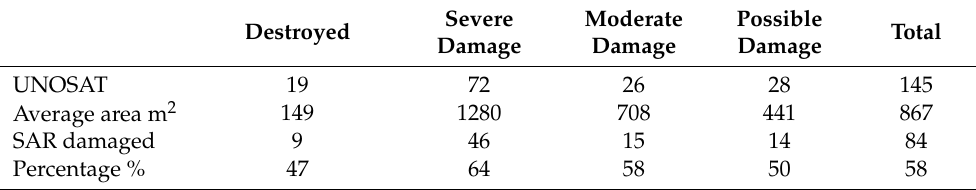
Figure 9. The comparison of the Sentinel-1 SAR intensity-based results with the UNOSAT’s building damage assessment report. Table 3. The statistics of UNOSAT damage levels and SAR intensity-based damaged